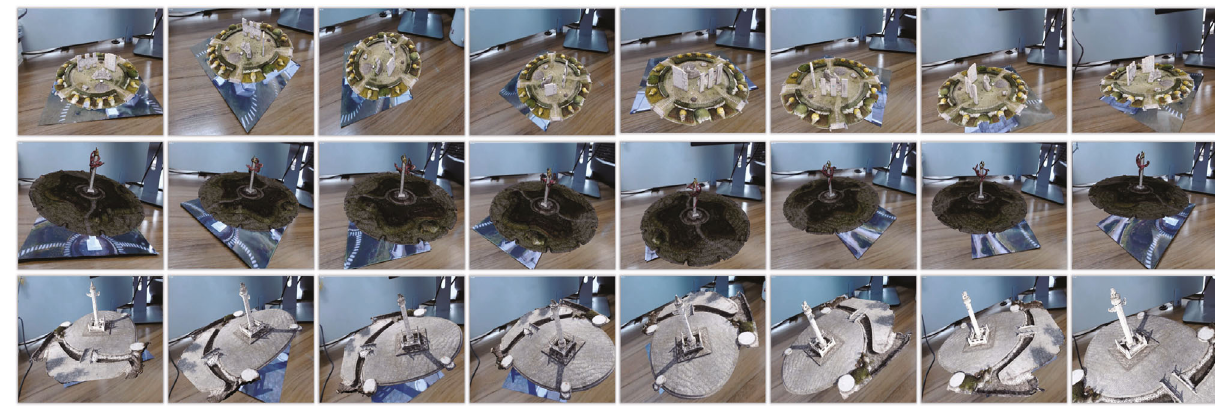
Figure 10: Di ff erent angle fusion e ff ect. Table 2: Quantitative information about the reconstructed model ’ s vertices, edges, faces, etc.